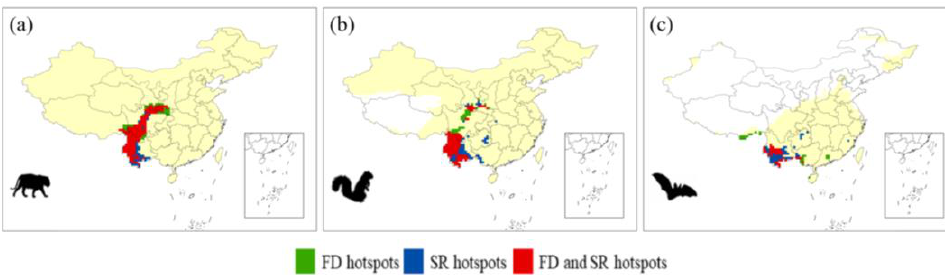
Figure 4. Geographic distributions of functional diversity (FD) hotspots and species richness (SR) hotspots of different groups of mammals. The green indicates FD hotspots, dark blue indicates SR hotspots and red indicates FD and SR hotspots. ( a ): Mammalian species besides Rodentia and Chiroptera; ( b ): Rodentia; ( c ): Chiroptera. Silhouettes were downloaded from PhyloPic (www.phylopic.org, accessed on 14 December 2020). The map content approval number is GS(2019)1822.